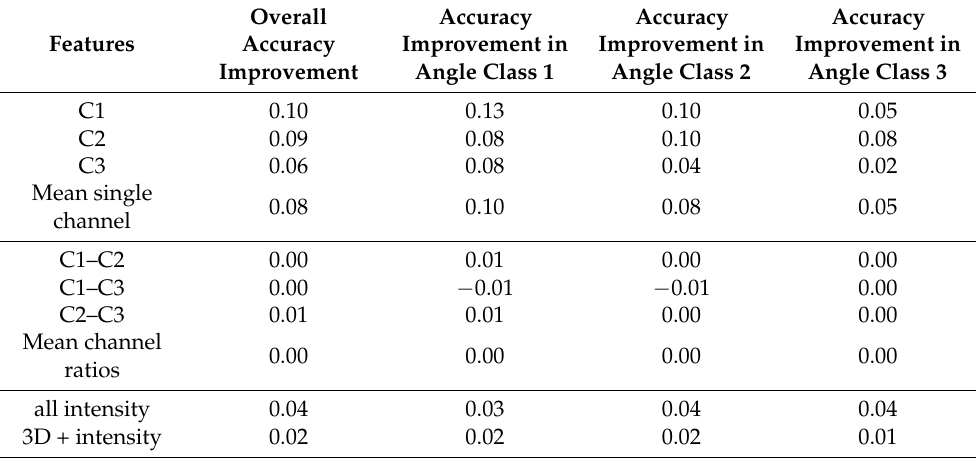
Table 7. Improvement in accuracy between classifications using normalized intensity features compared to classifications using raw intensity features. Results are presented as overall (second column) and by mean scan angle class (columns 3–5), for classifications with different feature selection (rows). Cases that were improved by ≥ 0.10 are highlighted in